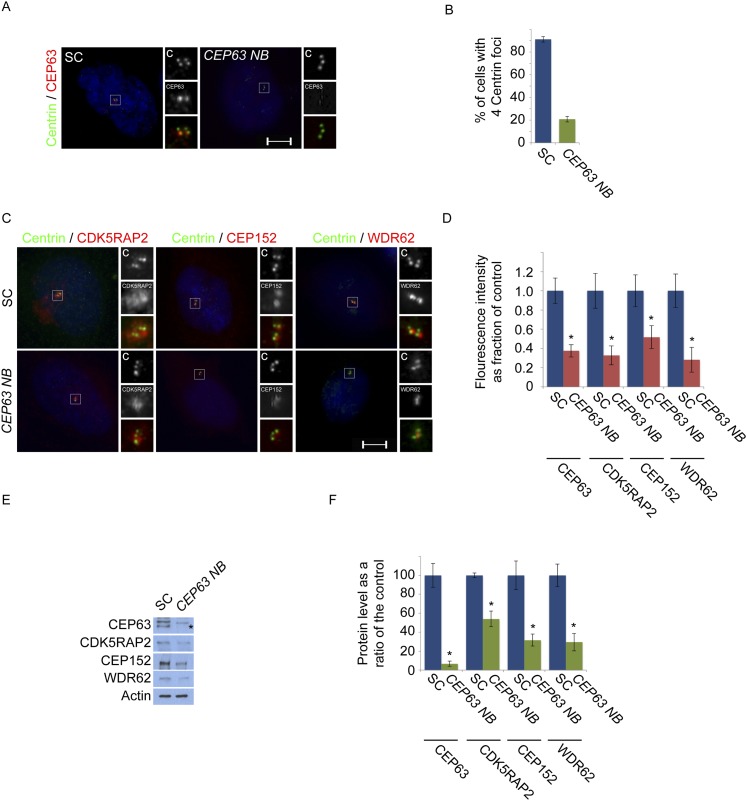
CEP63-depletion using a previous published siRNA destabilizes MCPH proteins.(A) HeLa cells in S phase transfected with SC or CEP63 Nicola Brown (NB) siRNA were co-stained with Centrin (‘c’, green) and CEP63 (red). (B) Quantification of the mean percentage of SC and CEP63 NB siRNA treated cells in S phase with four centrioles. (C) S phase HeLa cells transfected with SC and CEP63 NB siRNA were co-stained with Centrin (‘c’, green) and CDK5RAP2 (red), CEP152 (red), or CEP63 (red). (D) Quantification of the mean fluorescence intensities ±s.d. of CDK5RAP2, CEP152, WDR62 and CEP63 in SC and CEP63 NB siRNA treated cells expressed as the mean percentage ±s.d. of the fluorescence intensities of SC cells. For all quantifications 30 cells were analyzed per experiment (n = 3). p < 0.005 (paired t-test) statistically significant differences from SC controls are denoted by an asterisk. (E) Total cell lysates of SC and CEP63 NB siRNA treated cellswere analyzed by Western blot with antibodies to CEP63, CDK5RAP2, CEP152, and WDR62. Actin served as a loading control. Asterisk indicates the specific band. (F) Quantification of the mean intensities ±s.d. of CEP63, CDK5RAP2, CEP152, and WDR62 in SC and CEP63 NB siRNA-treated cells expressed as the mean percentage ±s.d. of the intensities of SC samples. Actin served as a loading control and to normalize samples (n = 3). Asterisk denotes statistical significance compared to controls where p < 0.005 (paired t-test).